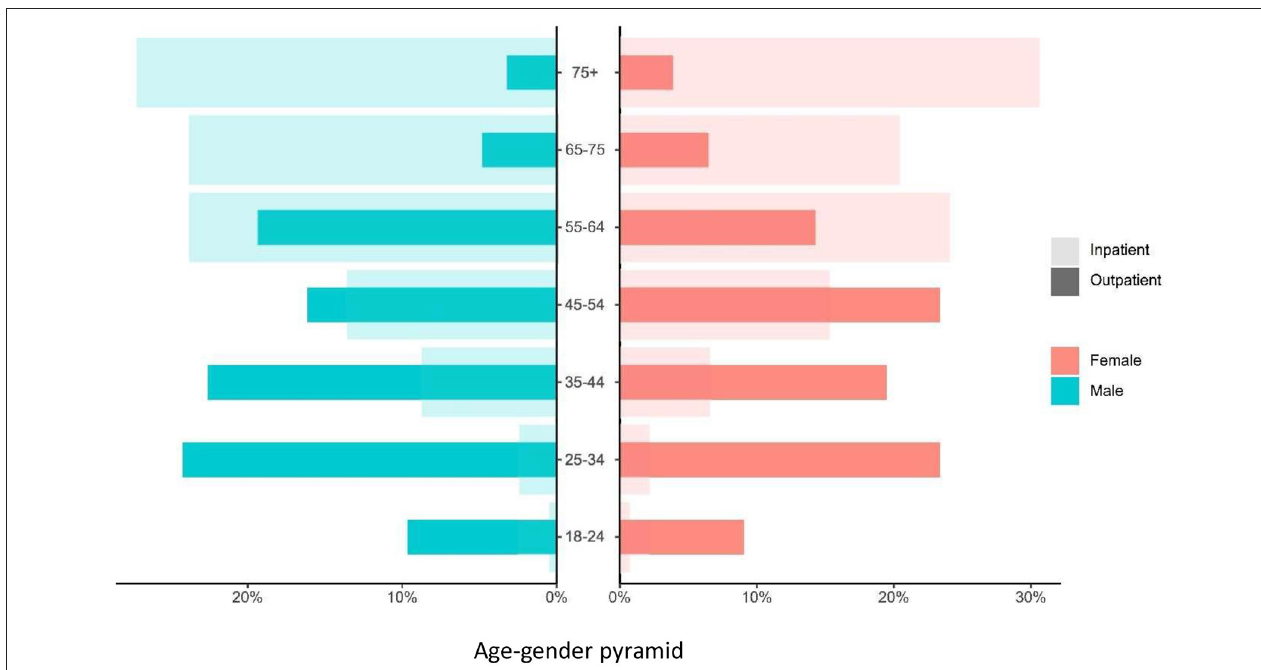
FIGURE 1 | Age and sex distribution in inpatients and outpatients with COVID-19. Dark- and light-shaded histograms represent nonadmitted (outpatients) and admitted (inpatients) patients with confirmed COVID-19 status, respectively. Red represents female patients and blue represents male